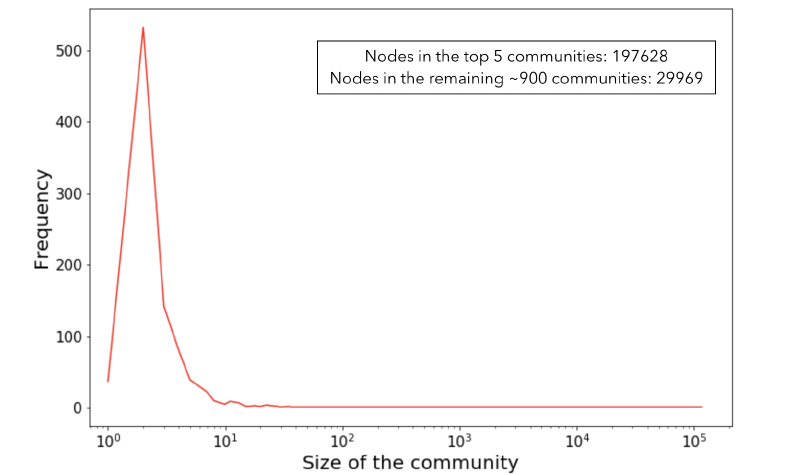
Figure 4. Size of the communities. There is a great number of micro-communities made of only two or three nodes. The first 5 communities group together 87% of the nodes, leaving out only 29,969